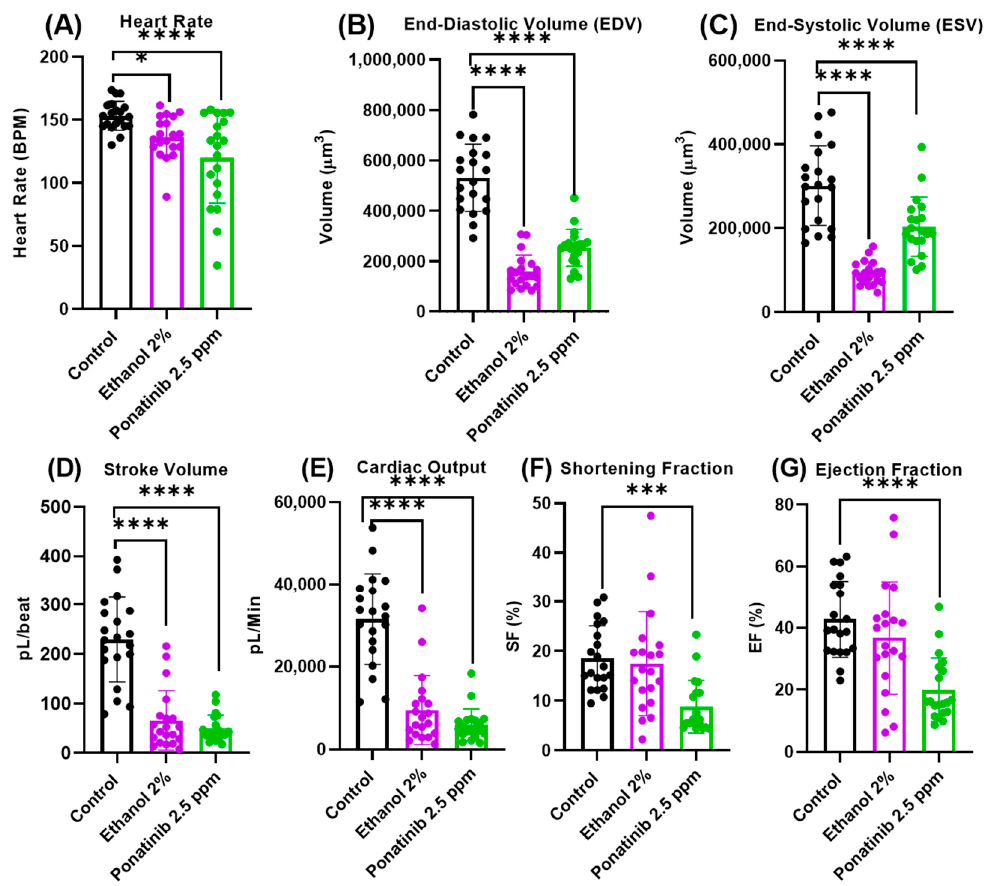
Figure 5. Cardiac physiology parameter comparison between control, ethanol 2%, and ponatinib 2.5 ppm analyzed by DLC method. Heart rate ( A ), end-diastolic volume ( B ), end-systolic volume ( C ), normalized stroke volume ( D ), cardiac output ( E ), shortening fraction ( F ), and ejection fraction ( G ). Results from control and chemical treatment were statistically analyzed by ordinary one-way ANOVA followed by Fisher’s LSD test as post hoc multiple comparison test. Data are expressed as mean ± SD and statistical difference is indicated by * p < 0.05; *** p < 0.001; and **** p < 0.0001 ( n = 20).